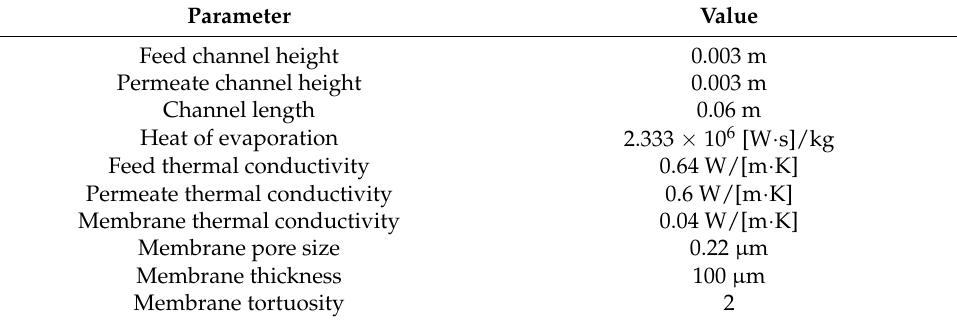
Table 1. Summary of CFD model parameters.